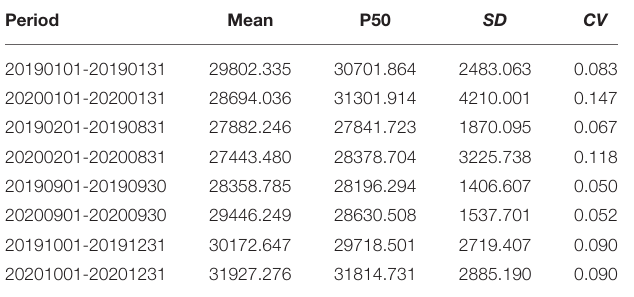
TABLE 1 | Descriptive statistics of China’s daily CO 2 emissions in 2019 and